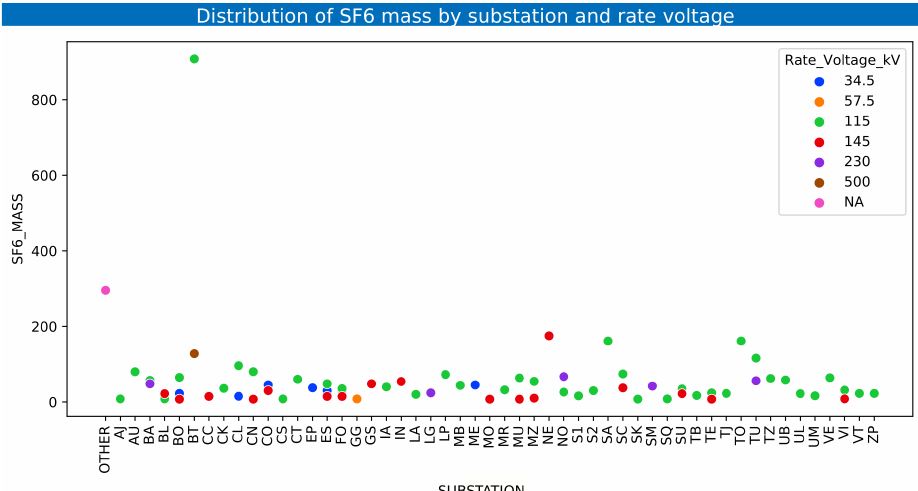
Figure 3. Distribution of SF 6 mass based on ENEL-CODENSA assets data.